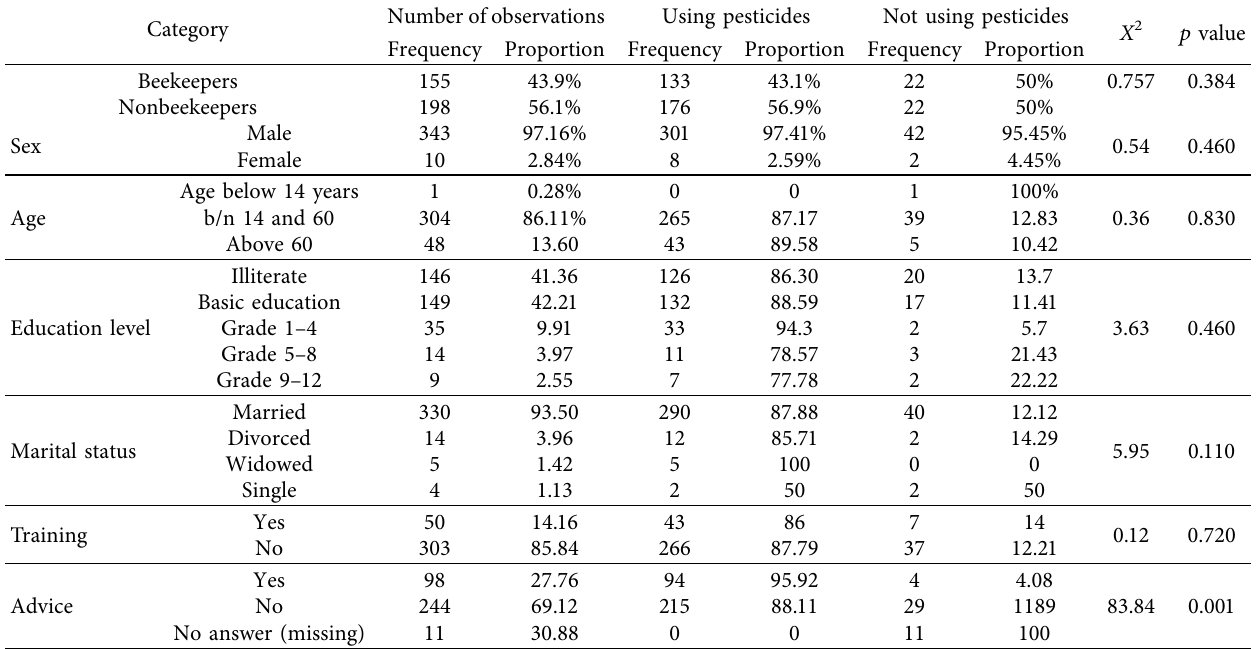
Table 2: Utilization of pesticides by beekeepers and nonbeekeepers and demographic characteristics of respondents. Number of Category